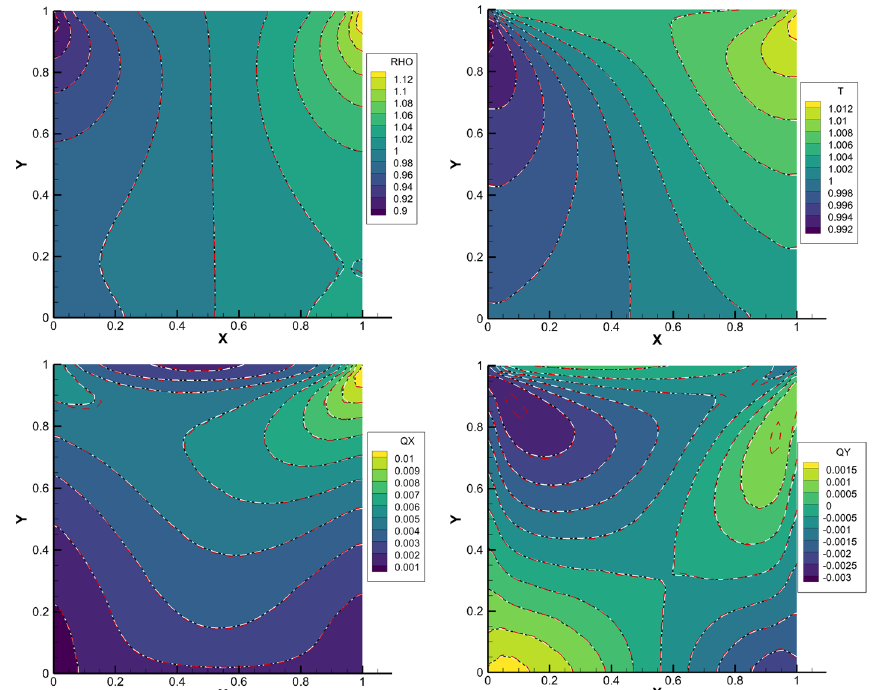
Fig. 2 Comparison of density, temperature, x -component of heat flux and y -component of heat flux contours for lid-driven cavity flow at Kn 1 (ADUGKS: colored background; DUGKS: white dash-dot line; = UGKS: red dash line)